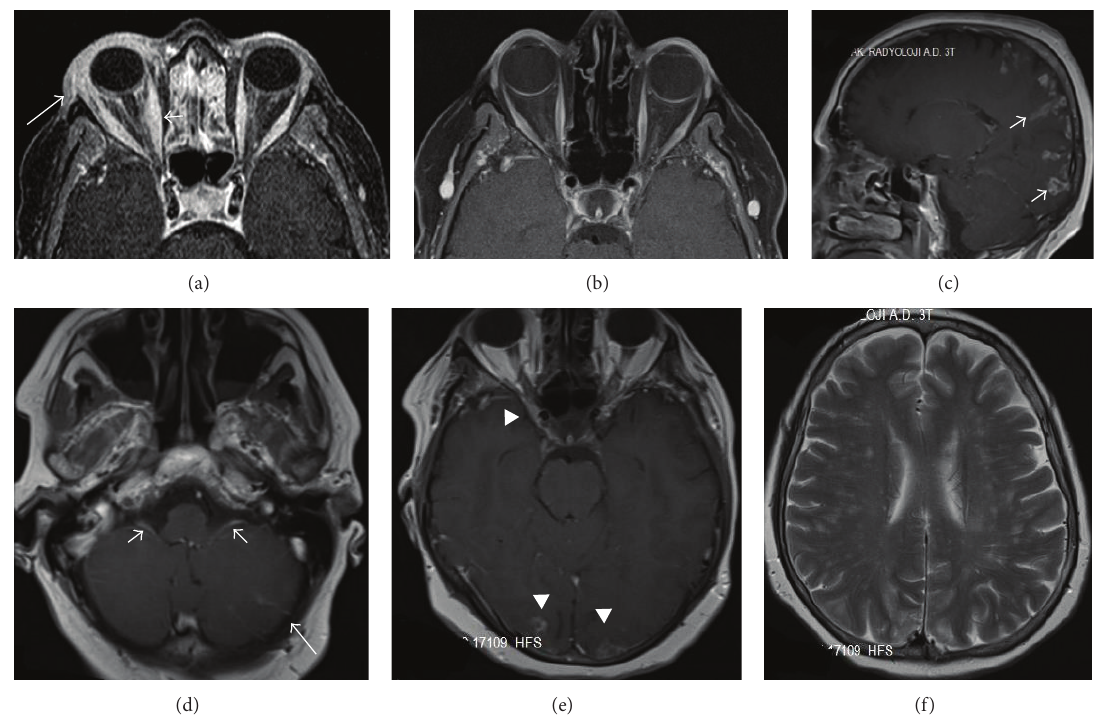
Figure 1: Thickening of the medial rectus muscle (short arrow; right diameter 9.5 mm; left diameter 5.8 mm) with gadolinium enhancement of the right lacrimal gland (long arrow) and periorbital fatty tissue in the axial fat-suppressed postcontrast T1-weighted sequences (a). The lacrimal gland and the medial rectus muscle appear normal in the axial fat-suppressed postcontrast T1-weighted sequences (b). Pial-gyral nodular gadolinium-enhanced lesions (short arrow) are detected in the bilateral occipital and parietal areas in the sagittal postcontrast T1- weighted sequences (c). Pial gadolinium enhancement (long arrow) and diffuse enhancement of the 9th and 10th cranial nerves (short arrow) are observed in both cerebellar hemispheres in the axial postcontrast T1-weighted sequences (d). Pial-gyral nodular gadolinium enhancement was also observed to be adjacent to the right optic foramen and the bilateral occipital area in axial postcontrast T1-weighted sequences (arrowhead) (e). In axial T2-weighted sequences, hyperintense multiple nodular lesions were detected in the bilateral periventricular white matter